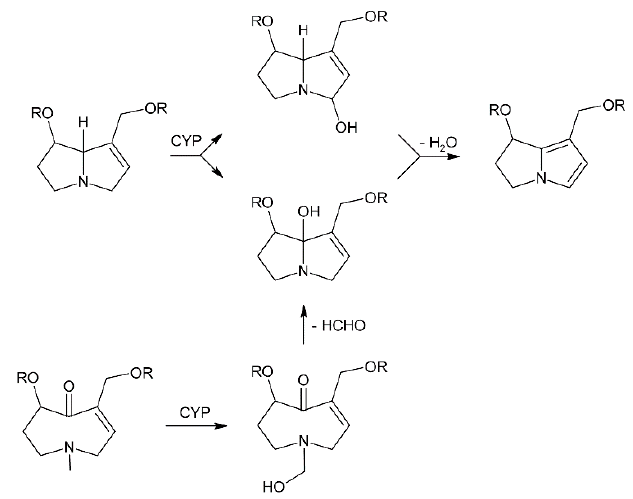
Figure 16. Metabolic activation of pyrrolizidine alkaloids. PAs are oxidized by cytochrome P450 enzymes (CYP), which converts them to the reactive and toxic pyrrole derivatives. Adapted from Reference [11].